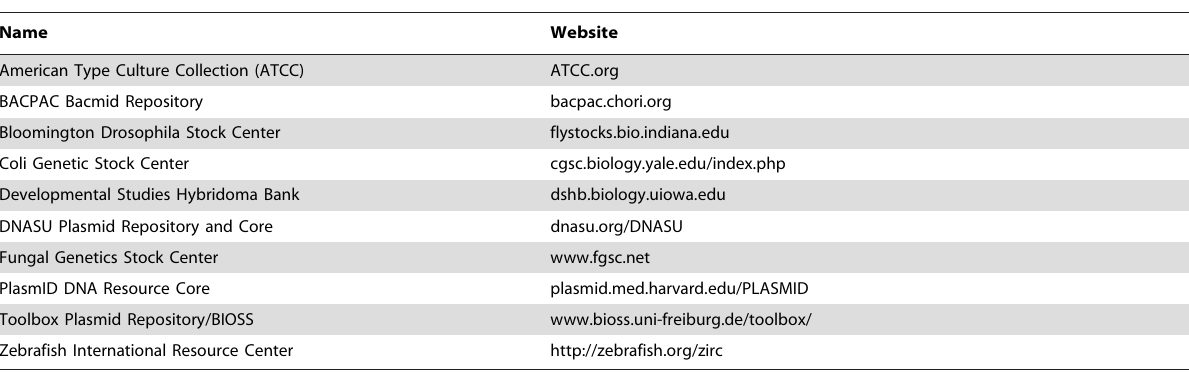
Table 1. Examples of biological resource centers.